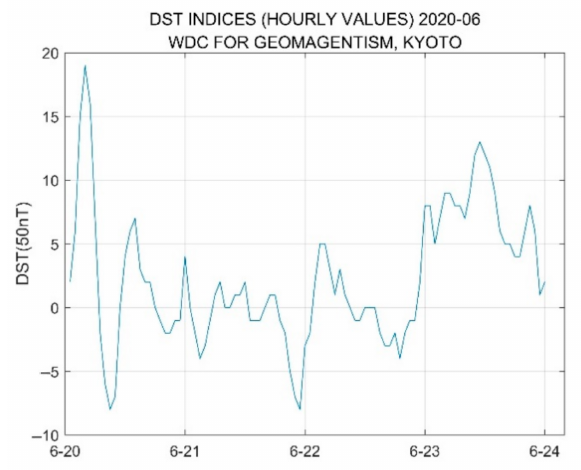
Figure 12. Observation data of Dst from 20 June to 24 June 2020.